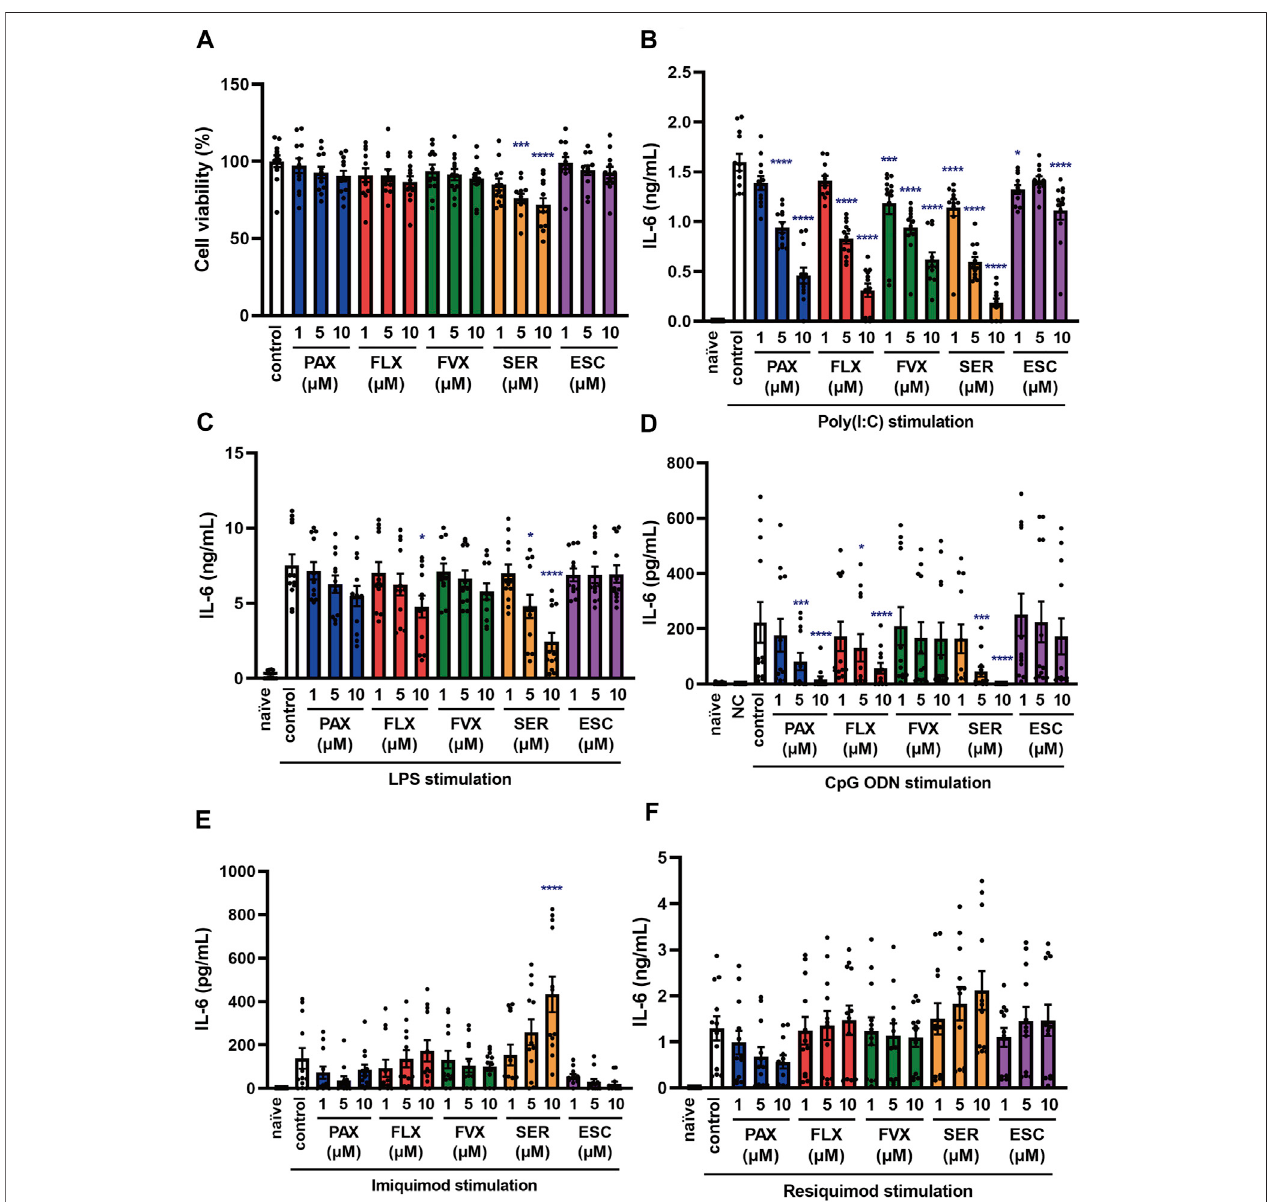
FIGURE 5 | Effects of SSRIs on IL-6 production induced by TLR agonists in BMDCs. (A) BMDCs were incubated with each SSRI (1 – 10 µM) for 24 h. Cell viability wasevaluatedbyMTTassay. (B – F) BMDCswerepre-incubatedwitheachSSRI(1 – 10 µM)for30 minandthenincubatedwithpoly(I:C)(10 μ g/ml) (B) ,LPS(1 μ g/ml) (C) , CpG ODN or negative control ODN (200 ng/ml) (D) , imiquimod (1 μ g/ml) (E) or resiquimod (10 ng/ml) (F) for 24 h. IL-6 was measured by means of ELISA. Error bars indicate ±SE [ (A – F) : n = 12, three independent experiments]. Statistical analysis was performed by one-way ANOVA followed by Dunnett ’ s test. Signi fi cant differences between control and test groups are indicated by * p < 0.05, *** p < 0.001, **** p < 0.0001. NC, negative control ODN. PAX, paroxetine; FLX, fl uoxetine; FVX, fl uvoxamine; SER, sertraline; ESC, escitalopram.